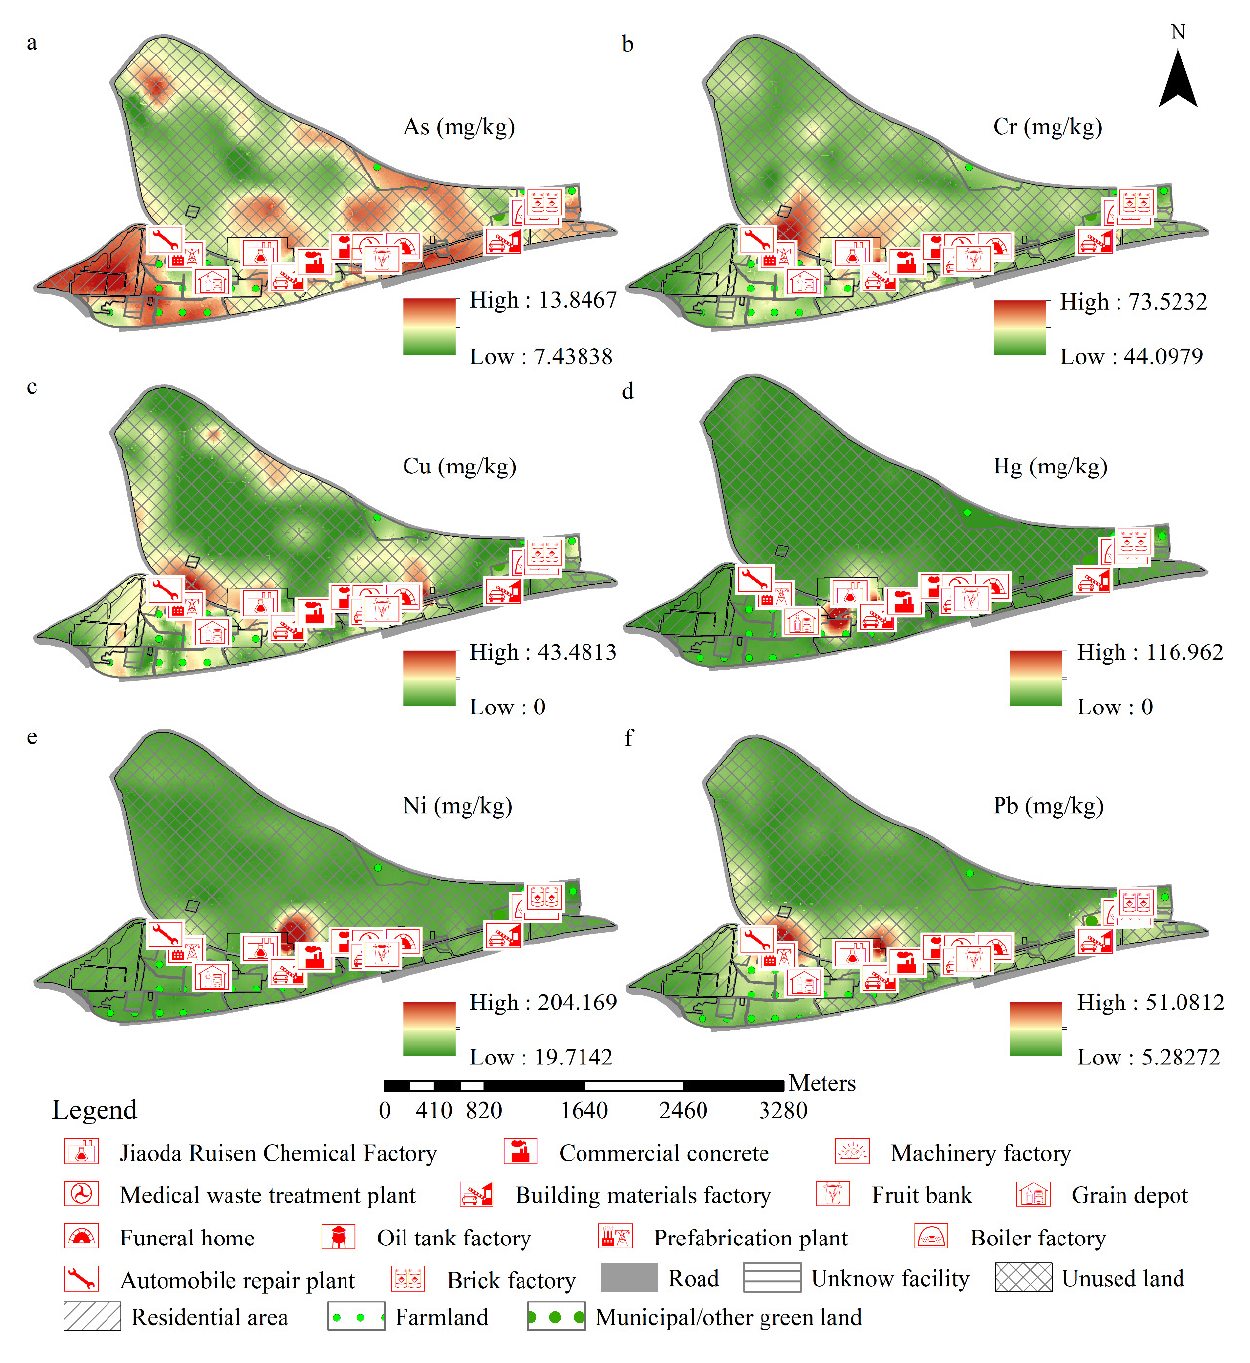
Figure 3. Spatial distribution of PTEs in the soil surrounding various facilities in the study area. ( a ) As; ( b ) Cr; ( c ) Cu; ( d ) Hg; ( e ), Ni; ( f ) Pb.